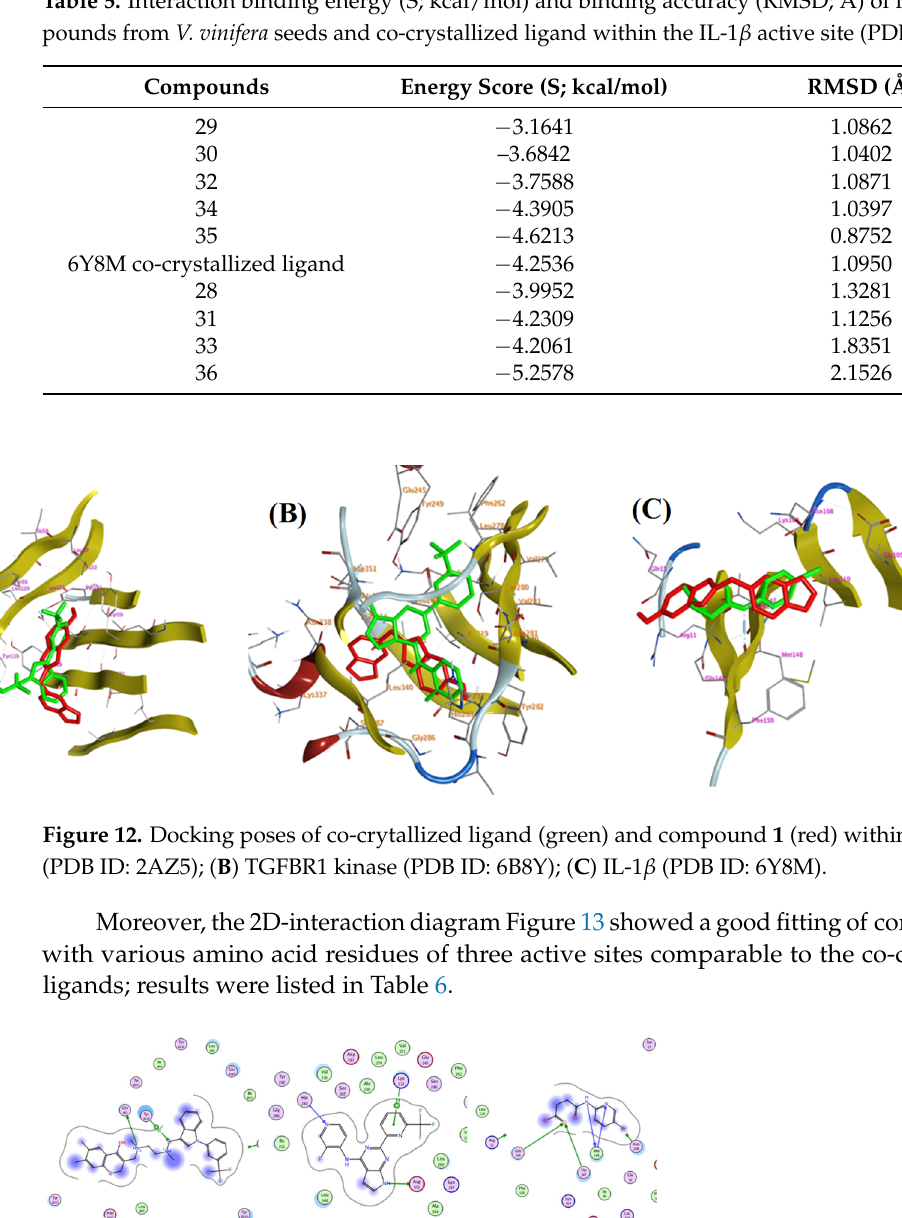
Figure 13. Showing 2D-binding interactions of co-crystallized ligand ( A1 – A3 ) and compound 1 ( B1 – B3 ) within active sites of: TNF α (PDB ID: 2AZ5); TGFBR1 kinase (PDB ID: 6B8Y); and IL-1 β (PDB ID: 6Y8M).